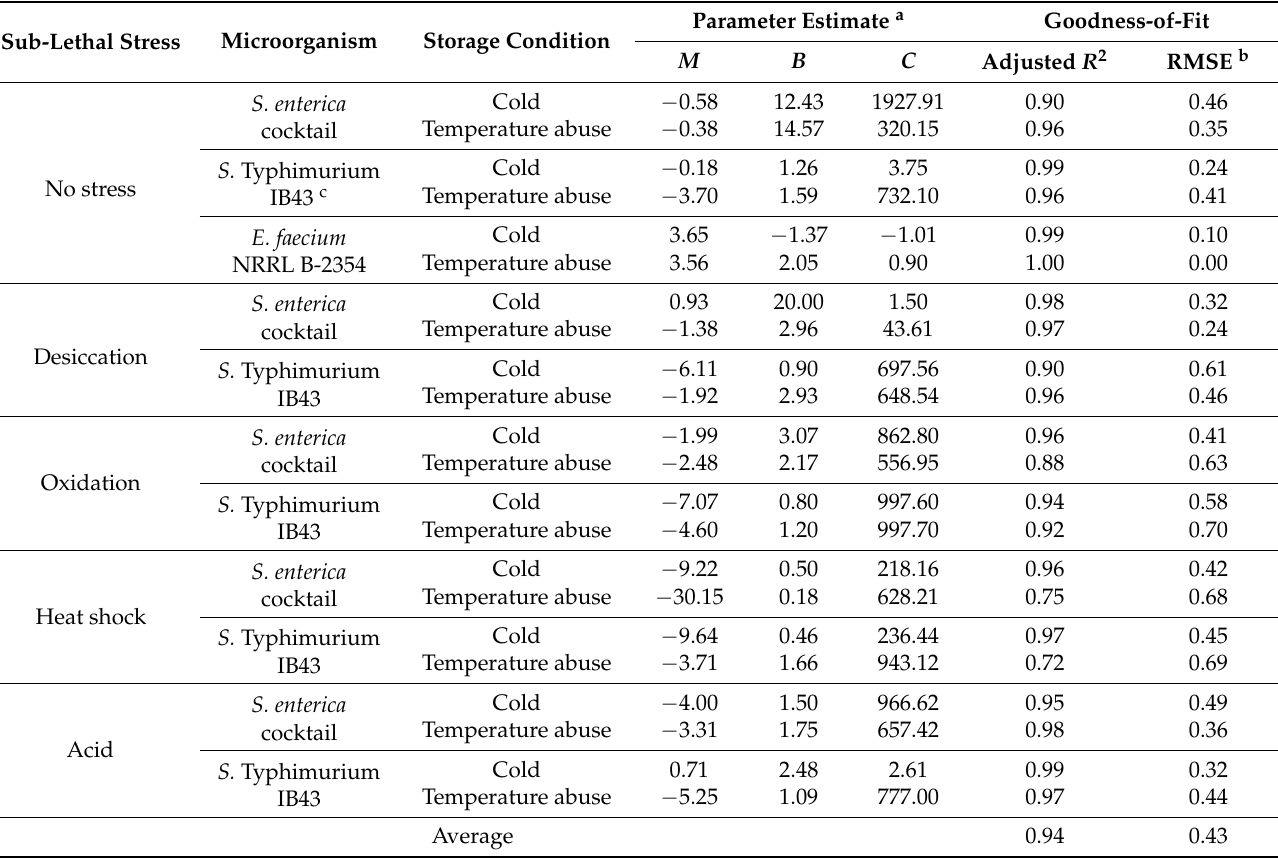
survival curves (average adjusted R 2 : 0.94; average RMSE: 0.43), closely followed by the Weibull model (average adjusted R 2 : 0.92; average RMSE: 0.45) and the Geeraerd model (average adjusted R 2 : 0.92; average RMSE: 0.47). The performance of the log-logistic model and the biphasic model was comparable, both yielding an average adjusted R 2 of 0.89 and an average RMSE of 0.46. Table 1. Parameter estimates and goodness-of-fit of the modified Gompertz model for the persistence of S. enterica and E. faecium NRRL B-2354 on baby spinach under cold and temperature abuse conditions with or without prior exposure to sub-lethal